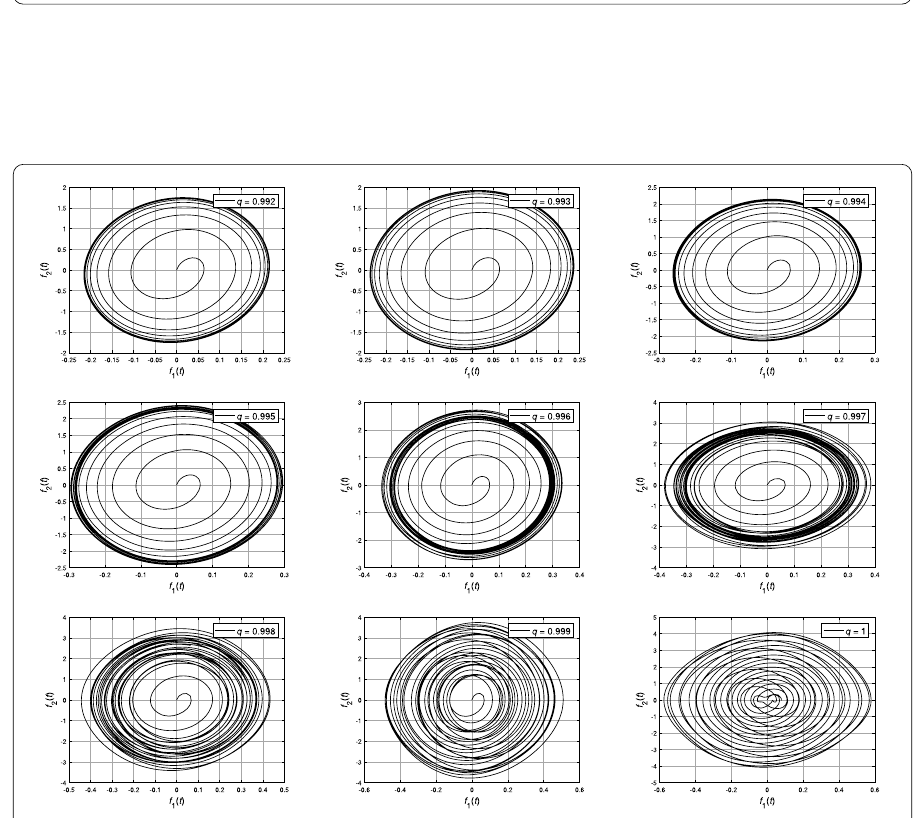
Figure 3 The phase-portraits of the fractional suspension system (13) for q = 0.992,0.993,0.994,0.995,0.996,